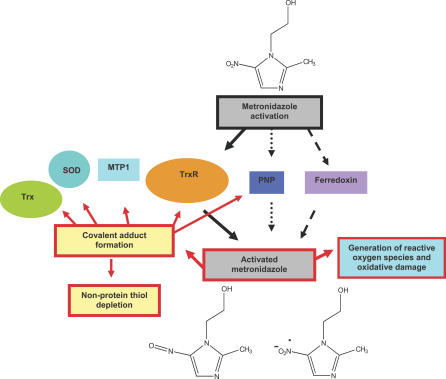
Model of Metronidazole Activation and Metronidazole Action in E. histolytica
After uptake by the cell, metronidazole is reduced by thioredoxin reductase (TrxR) (as shown in this study; black arrow), possibly by purine nucleoside phosphorylase (hypothesized in this study; dotted arrow) and, probably, by ferredoxin (shown to reduce metronidazole in T. vaginalis and G. intestinalis; interrupted arrow). After activation, metronidazole can develop its toxicity in a 2-fold way, either as a nitroradical anion or, if further reduced, as a reactive nitrosoimidazole (red arrows). The nitroradical anion can reduce O2 and thereby generate reactive oxygen species, which are highly detrimental to the microaerophilic E. histolytica cell. Alternatively, the nitrosoimidazole is generated, which forms adducts with non-protein thiols and/or proteins, resulting in the depletion of non-protein thiols and the modification of thioredoxin reductase (TrxR), thioredoxin (Trx), superoxide dismutase (SOD), metronidazole target protein 1 (Mtp1), and purine nucleoside phosphorylase (PNP). Presumably, these five proteins become targets of modification due to their close spatial proximity to the site of metronidazole activation, i.e., thioredoxin reductase. The formation of covalent metronidazole adducts with proteins involved in antioxidant defense is likely to render the cells more vulnerable to oxidative stress, thereby exacerbating metronidazole toxicity to E. histolytica in the presence of oxygen [43].